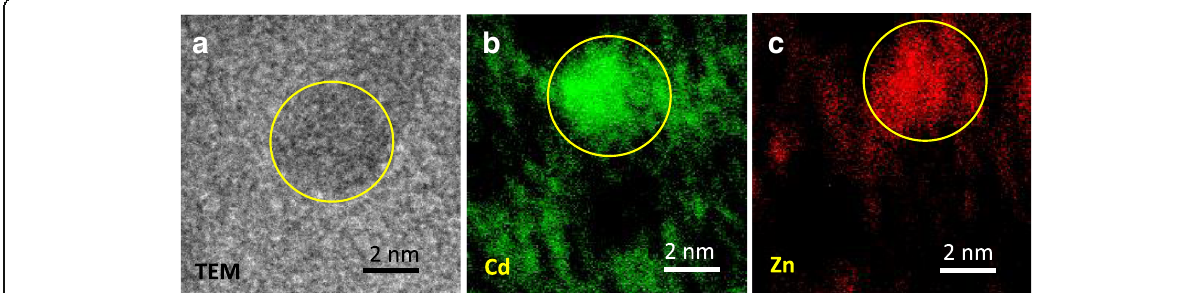
Fig. 6 EELS and EFTEM analyses of conjugates. EFTEM Elemental maps of Cd and Zn in samples of Zn 0.50 Cd 0.50 S quantum dots. a EFTEM zero energy loss image of an individual Zn